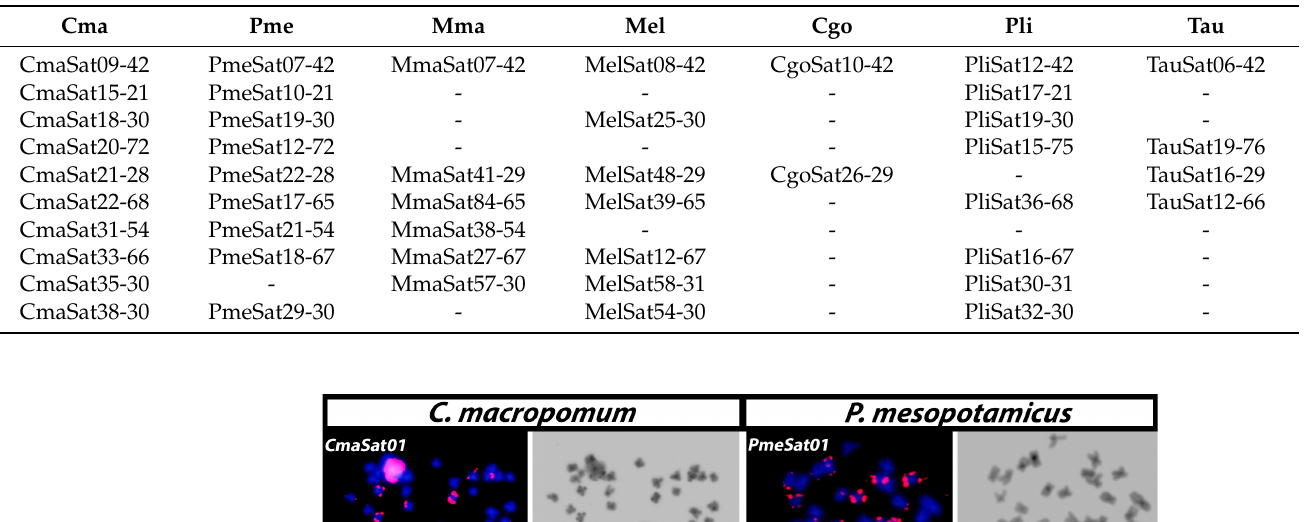
Table 4. Shared SatDNAs between C. macropomum , P. mesopotamicus and other Characiformes . Cma, Colossoma macropomum ; Pme, Piaractus mesopotamicus ; Mma, Megaleporinus macrocephalus ; Mel, Megale- porinus elongatus ; Cgo, Characidium gomesi ; Pli, Prochilodus lineatus ; and Tau, Triportheus auratus .